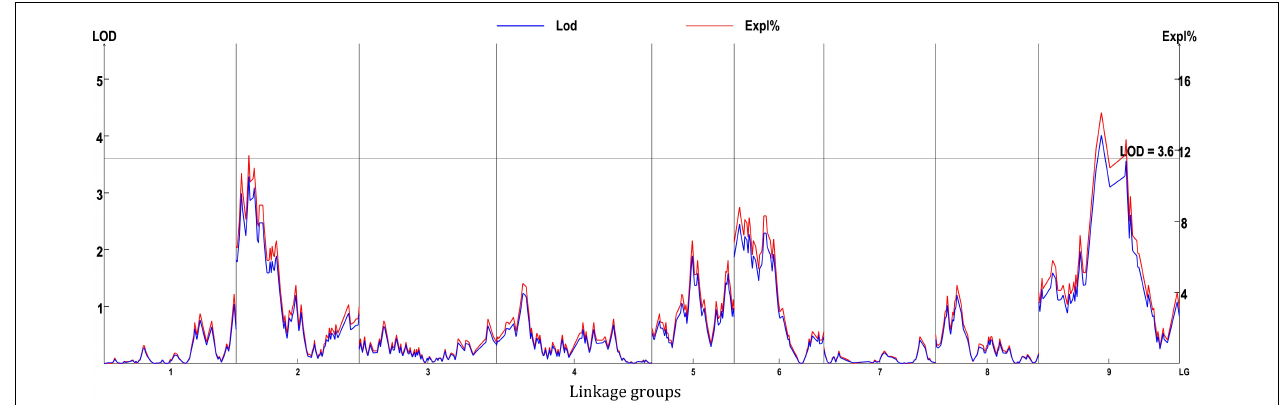
FIGURE 8 | Genome-wide scan using BLUE